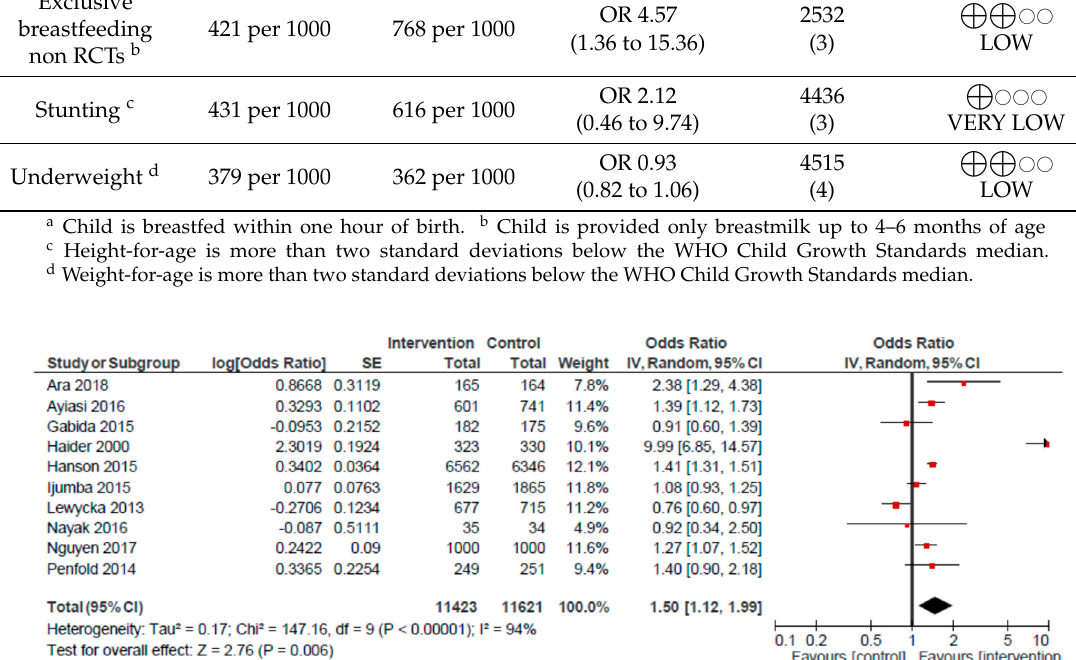
Figure 2. Forest plot of the meta-analysis of exclusive breastfeeding for home visits (randomized studies). Meta-analyses revealed no significant impact of the home visit platform, compared to usual care, on < 5 stunting (OR: 2.12; 95% CI: 0.46, 9.74; n = 3) and a nearly significant 7% decrease in the likelihood of < 5 underweight (OR: 0.93; 95% CI: 0.82, 1.06; n = 4). Table 1. Summary of outcomes for community healthcare worker (CHW)/peer counselor home visit platform. Outcomes